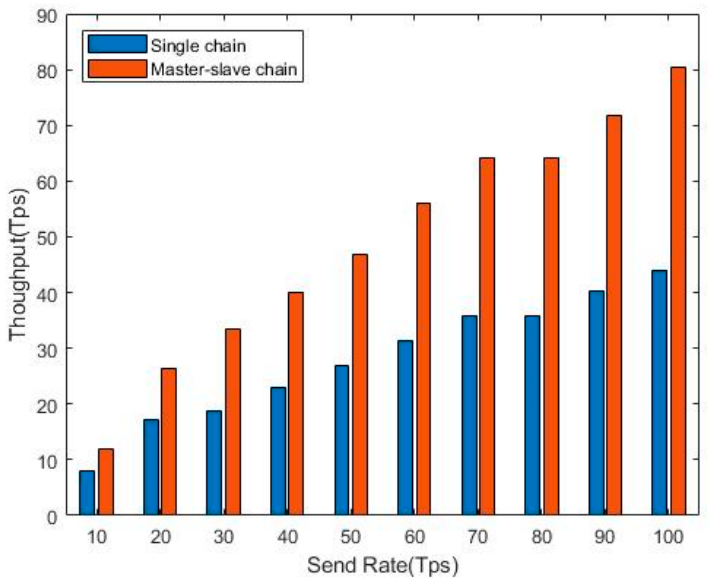
Figure 10. Throughput comparison between master–slave chains and single chains.